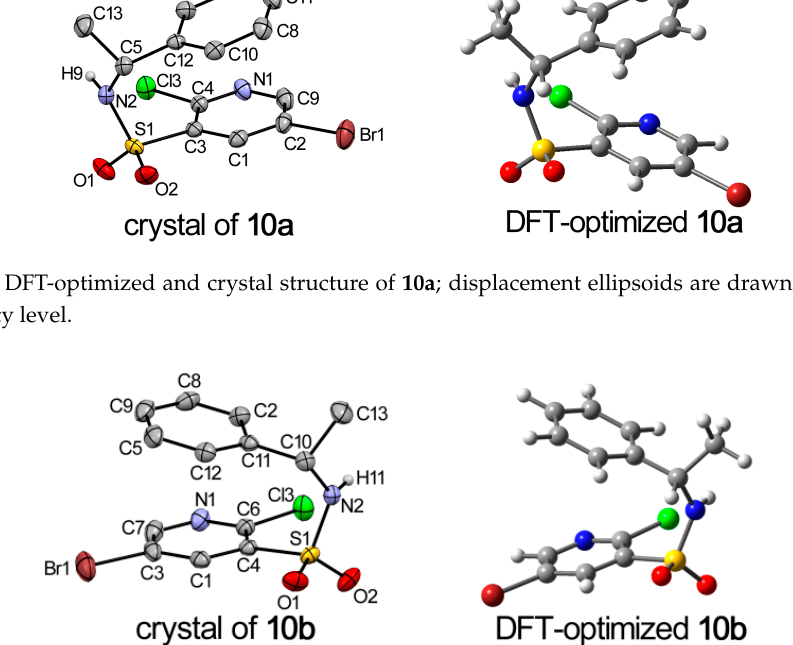
Table 1. Hydrogen-bond geometry (Å, °) of 10a .